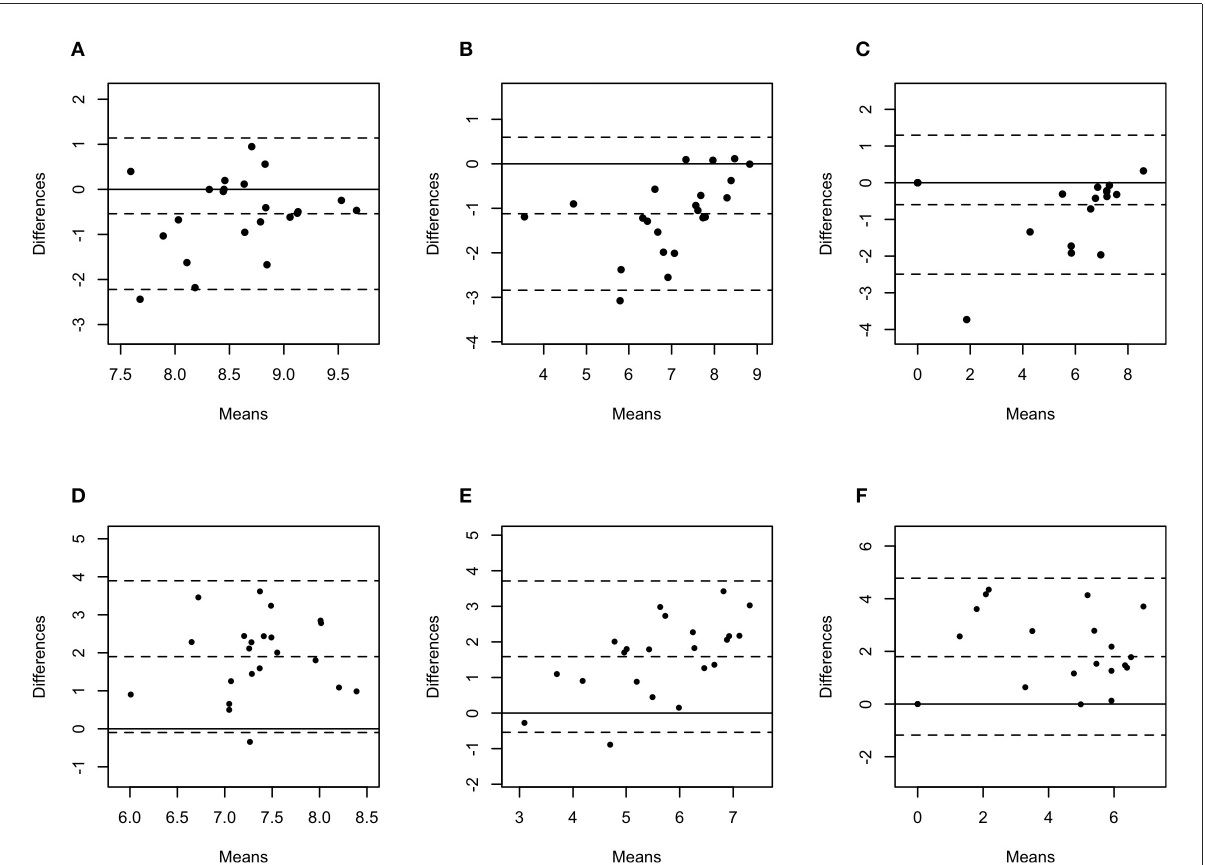
FIGURE5 Bland-Altman plots representing the agreement between the quantity of Treponema phagedenis (A) , Treponema medium (B) , and Treponema pedis (C) in biopsies and swabs, and T. phagedenis (D) , T. medium (E) , and T. pedis (F) in biopsies and aspirates. The center dotted represents the mean of difference (bias), and the two contiguous dotted lines represent the upper and lower limit of 95% of agreement. The solid line crossing the axis at zero represents no difference between the sampling methods (perfect agreement; bias =